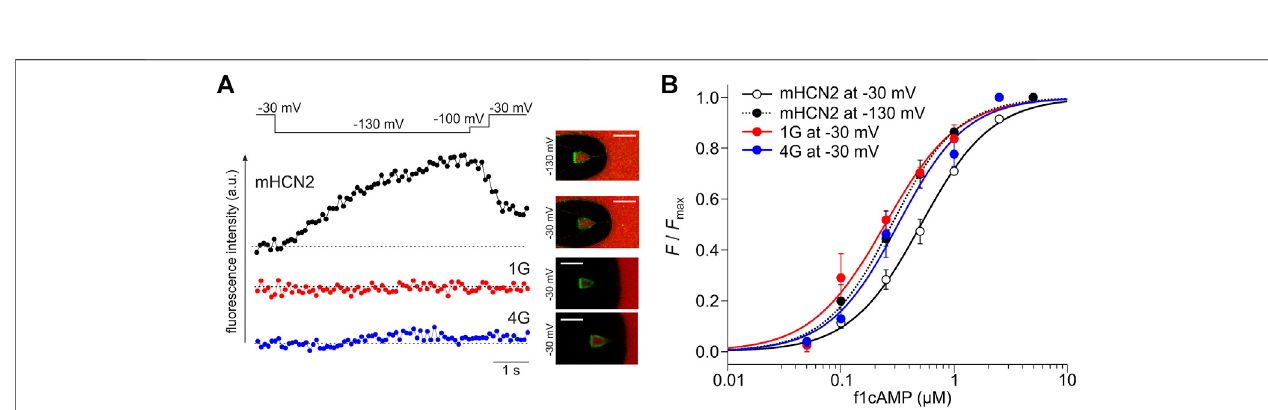
FIGURE 8 | Reciprocity between binding and gating in glycine constructs. (A) Examples of fl uorescence traces for HCN2, 1G, and 4G at 0.25 µM f1cAMP. The confocal fl uorescence images in the insets show pipette tips holding membrane patches with the given constructs expressed. Green fl uorescence arises from f1cAMP binding to the channel. (B) Concentration-binding curves for HCN2 at − 30 and − 130 mV, 1G at − 30 mV, and 4G at − 30 mV. Color coded lines were obtained by fi tting the Hill equation (Eq. Error! Digit expected.) tothe data points (dotted linefor mHCN2 at − 130 mV, solid lines for 1G, 4G and mHCNat − 30 mV). Single data points are averages of recordings from 3 to 20 different patches (except mHCN2 at 1 µM: n = 1).